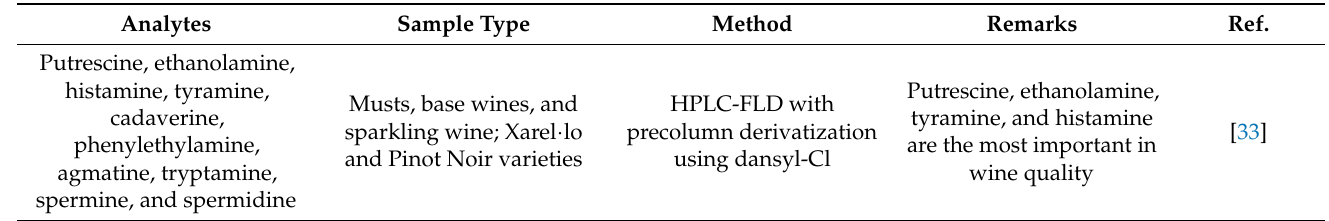
Table 1. Recent examples illustrating the potential role of BAs as quality